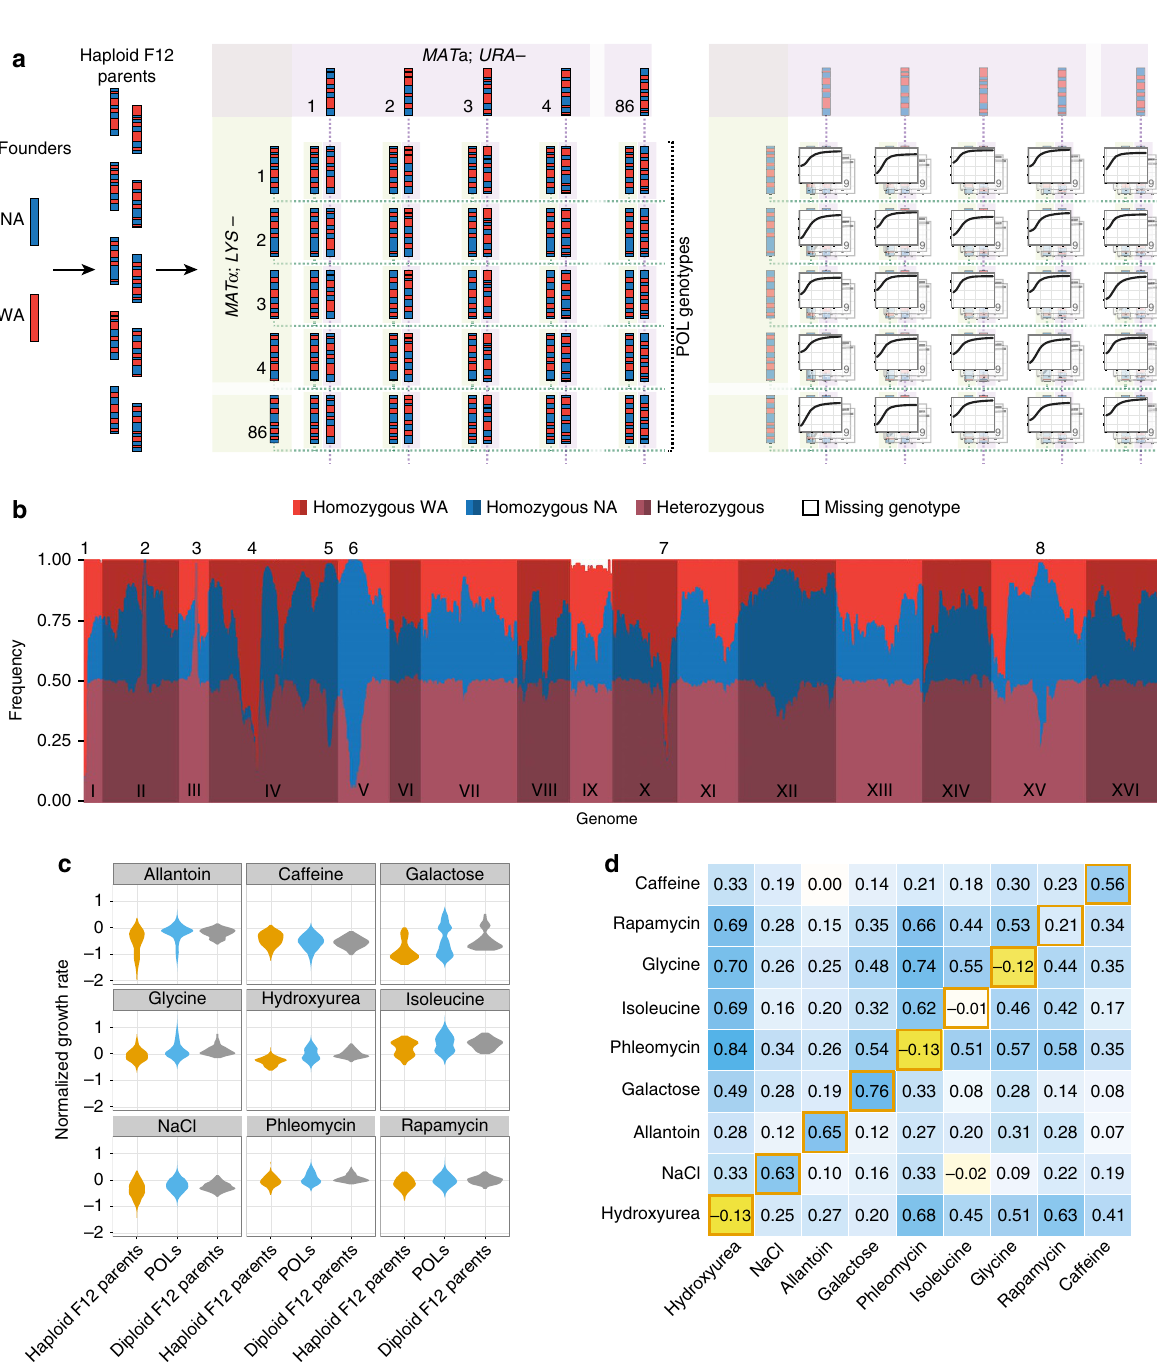
Figure 1 | An experimental framework for analysis of diploid traits. ( a ) Experimental design. Left panel: Advanced intercrossed lines were constructed by multiple rounds of random mating and sporulation of North American (NA) and West African (WA) genomes. Middle panel: We sequenced 172 of the resulting segregants and paired these to generate an array of 7,310 diploid hybrids (POLs). Right panel: The POLs and their F12 haploid parents were growth phenotyped in nine environments, providing high resolution growth curves. ( b ) Frequency of homozygotes (red: WA/WA, blue: NA/NA), heterozygotes (purple: NA/WA) and missing genotypes (white, mostly attributed to chr. IX aneuploidies) at each segregating site among the 7,310 POLs. Deviations from 50% heterozygosity are explained by selection (numbers 1, 4–8) against one allele in the F12 haploid parent construction, or by forced heterozygosity at the LYS2 (number 2) and MAT (number 3) loci. ( c ) Growth rate distributions of POLs (blue), their haploid F12 parents (orange) and the diploid parent estimates (grey, Methods). ( d ) Correlations (Pearson’s r) between the growth rate and mean growth for POLs within environments (lower left to upper right diagonal; orange borders), between growth rates (above diagonal) and mean growth (below diagonal) in pairs of environments. Colour intensity (3-colour scale: dark yellow to white to dark blue) and number indicate the degree of correlation r. depending on the trait, median 91%, Fig. 2, upper panel). On was 10% (2–45%), and for pairwise interactions this was 7% average, the proportion of phenotypic variance explained by (1–15%). Complete dominance of the functional NA over the additive effects was 73% (50–87%), for dominance effects this nonfunctional WA cluster of DAL genes 22 ensured a considerable NATURE COMMUNICATIONS|7:13311|DOI: